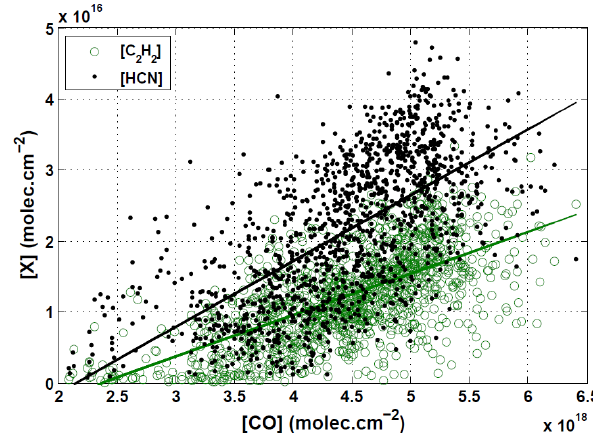
Fig. 6. Correlation plot between CO total columns and HCN (black dots) and C 2 H 2 (green circles) total columns for the day and region shown on Fig. 5. The correlation coefficients are 0.72 (1397 points) and 0.68 (1397 points) for HCN and C 2 H 2 ,